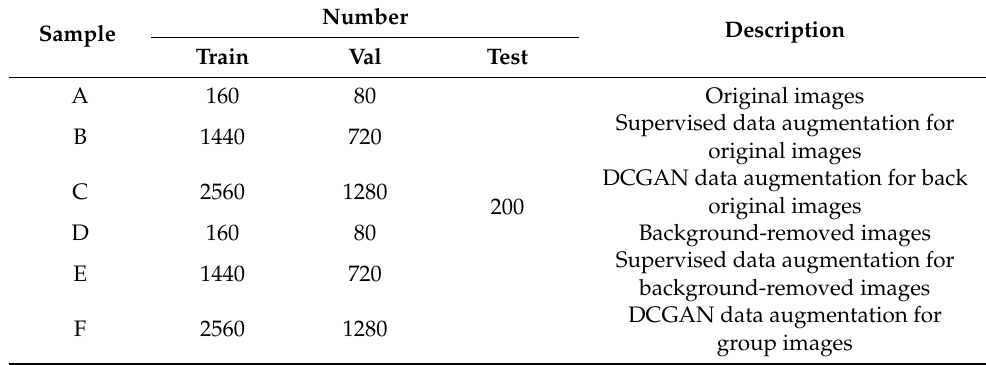
Table 7. Input datasets for the image recognition models.